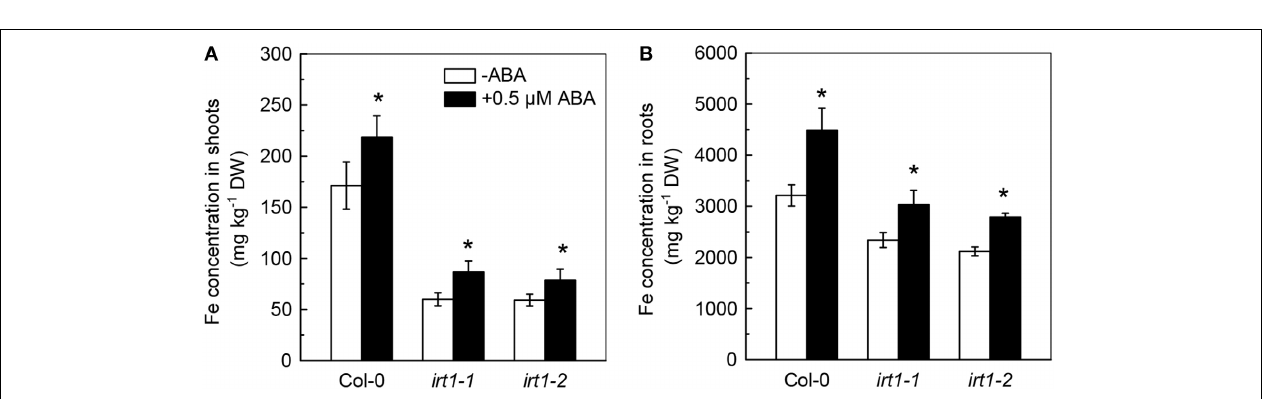
respectively. (A) Expression of IRT1 in roots. (B) Fe concentration in shoots. (C) Fe concentration in roots. Transcript level of IRT1 was normalized to that of UBQ10 mRNA (100%). Data are means ± SD ( n = 5). ∗ Significant differences ( P < 0 . 05) between ABA-free and ABA-added treatments.